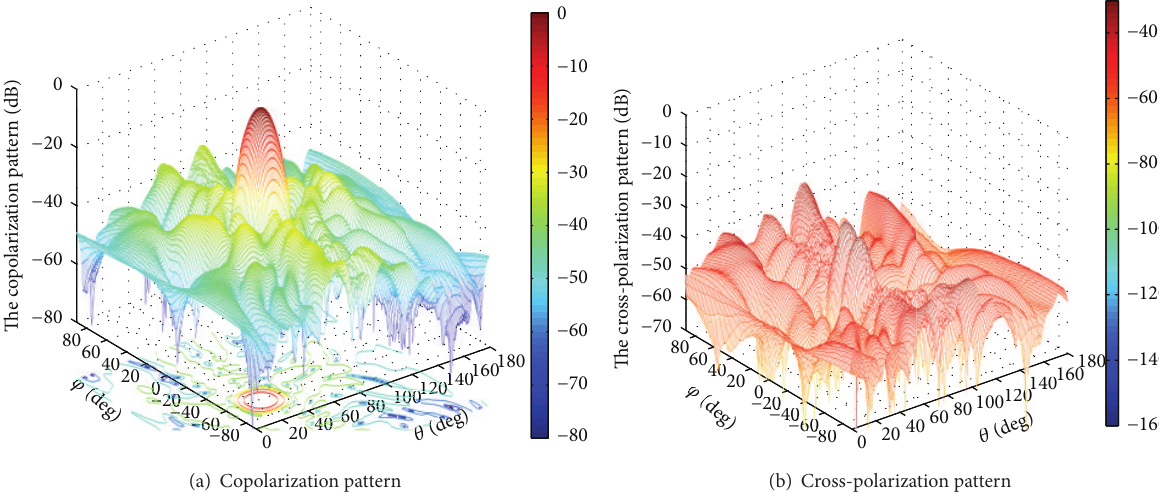
Figure 8: 3D radiation pattern of the conical conformal array for scan direction of (74 ∘ , 0 ∘ ) for solution A in Figure 7.